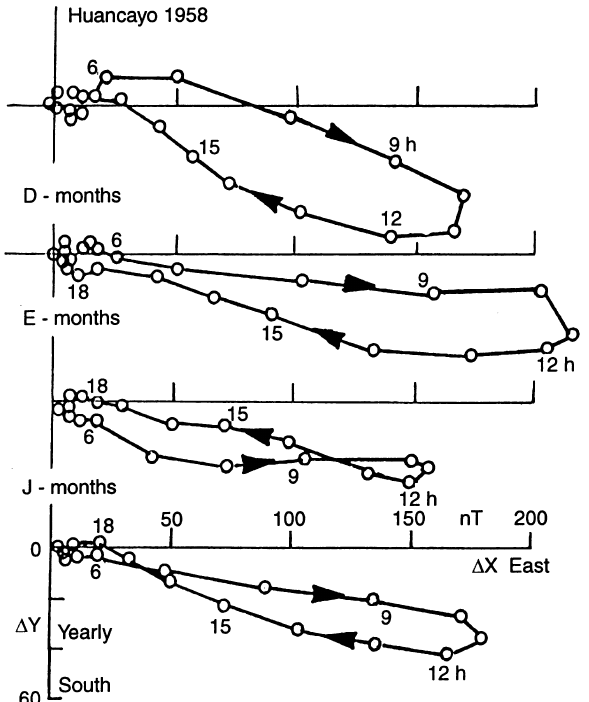
Fig. 4. The daily variations of the current vector at Huancayo during di(cid:128)erent seasons of 1958